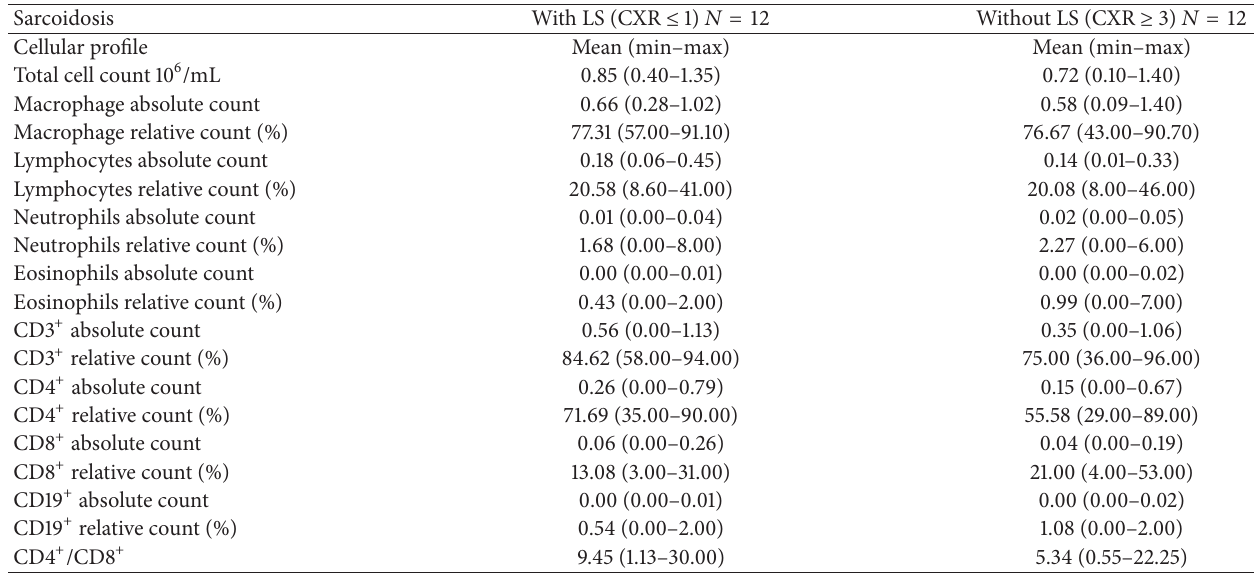
Table 2: Bronchoalveolar cellular profile in our patients with pulmonary sarcoidosis. Sarcoidosis With LS (CXR ≤ 1) 𝑁 = 12 Cellular